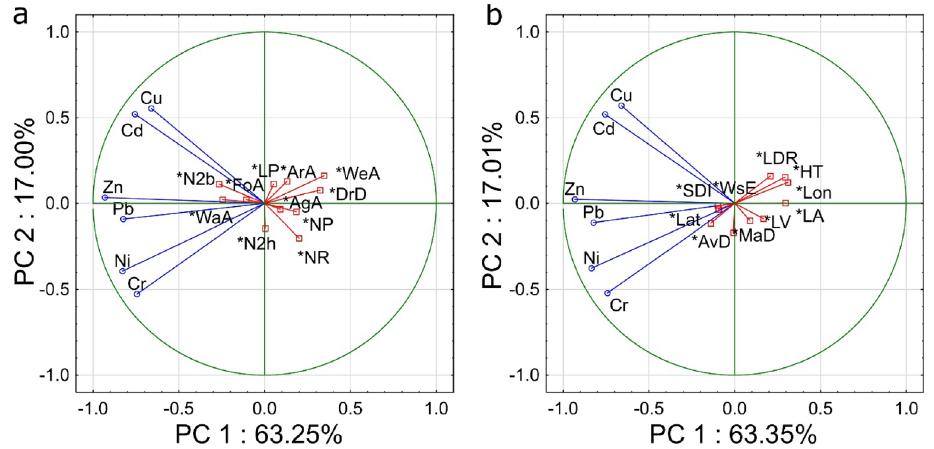
Figure 9. Results of PCA against parameters describing the lake catchment ( a ) and parameters describing the lake ( b